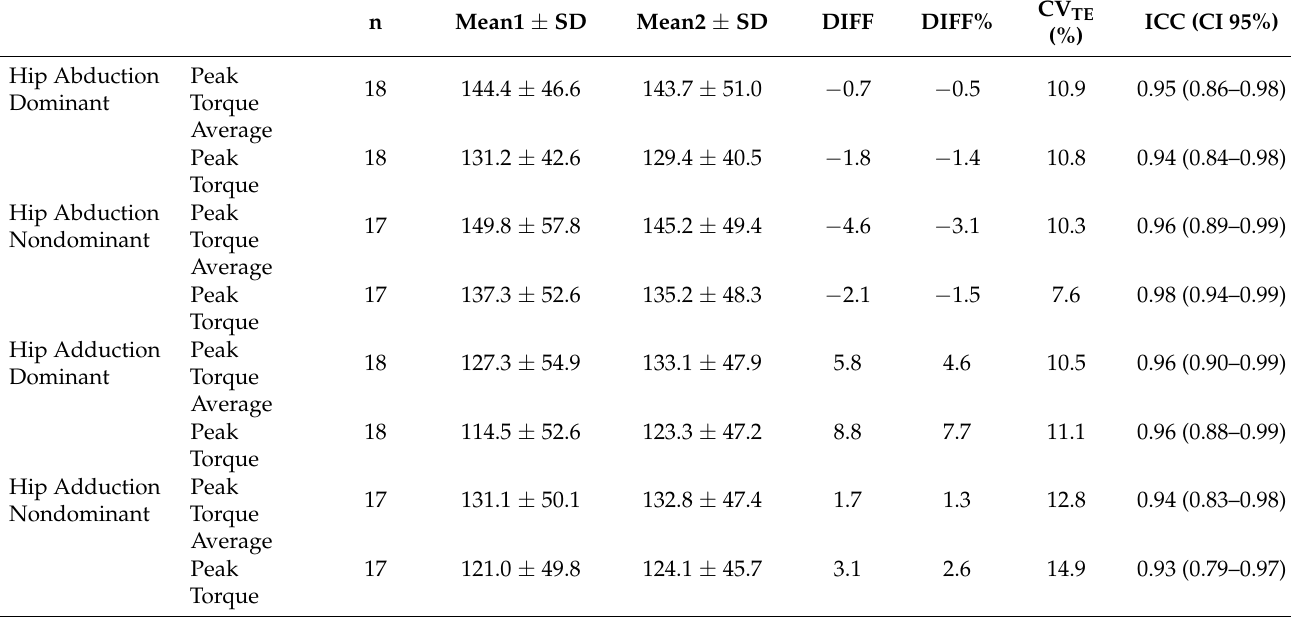
Table 4. Hip abduction and